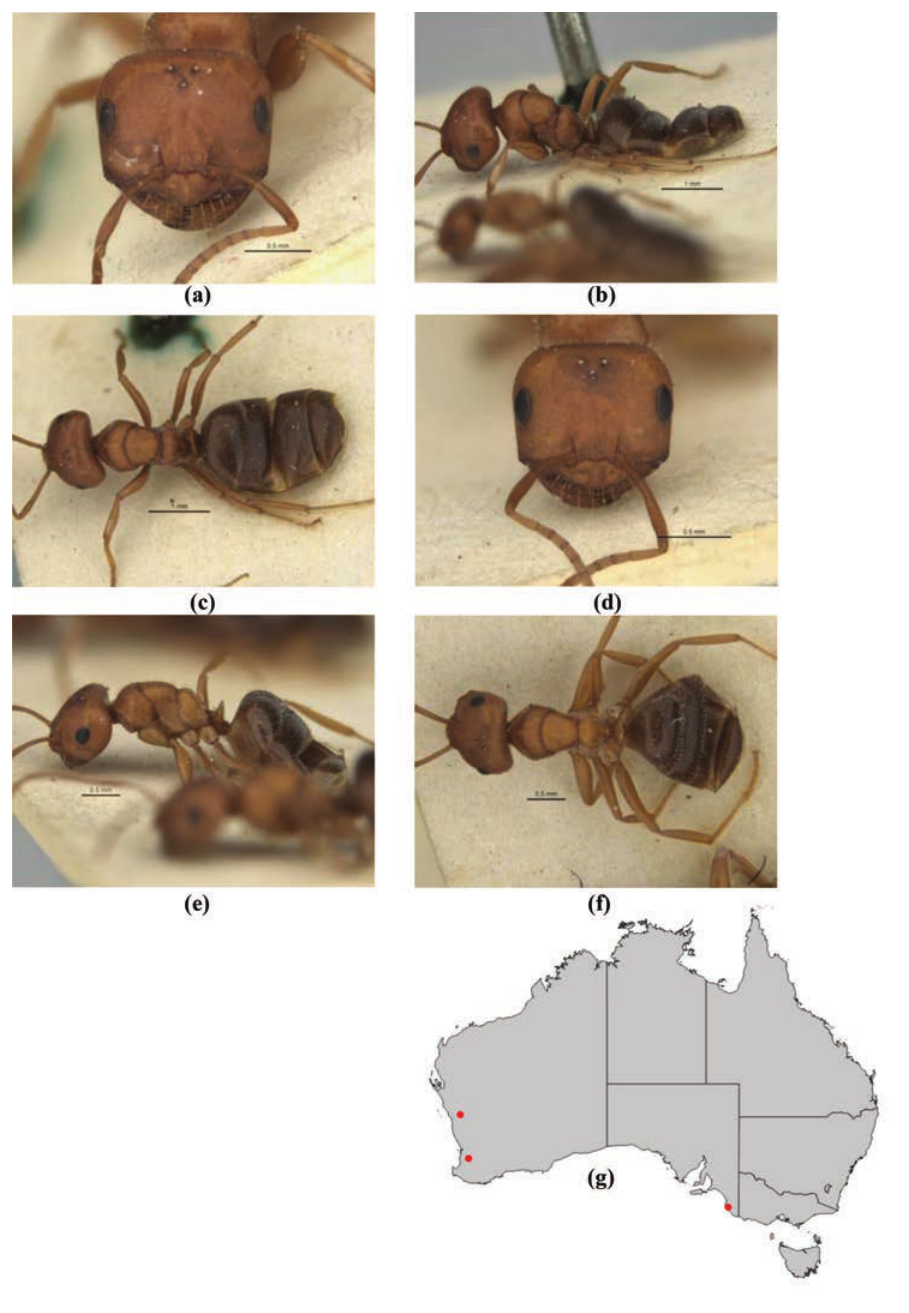
Figure 89. Melophorus barbellulatus sp. n.: major worker paratype (ANIC32-900080–ant nearest pin on top rectangle) frons ( a ), profile ( b ) and dorsum ( c ); minor worker holotype (ANIC32-900080–mid- dle ant on top rectangle) frons ( d ), profile ( e ) and dorsum ( f ); distribution map for the species ( g ). Low resolution scale bars: 1 mm ( b, c ); 0.5 mm ( a, d–f